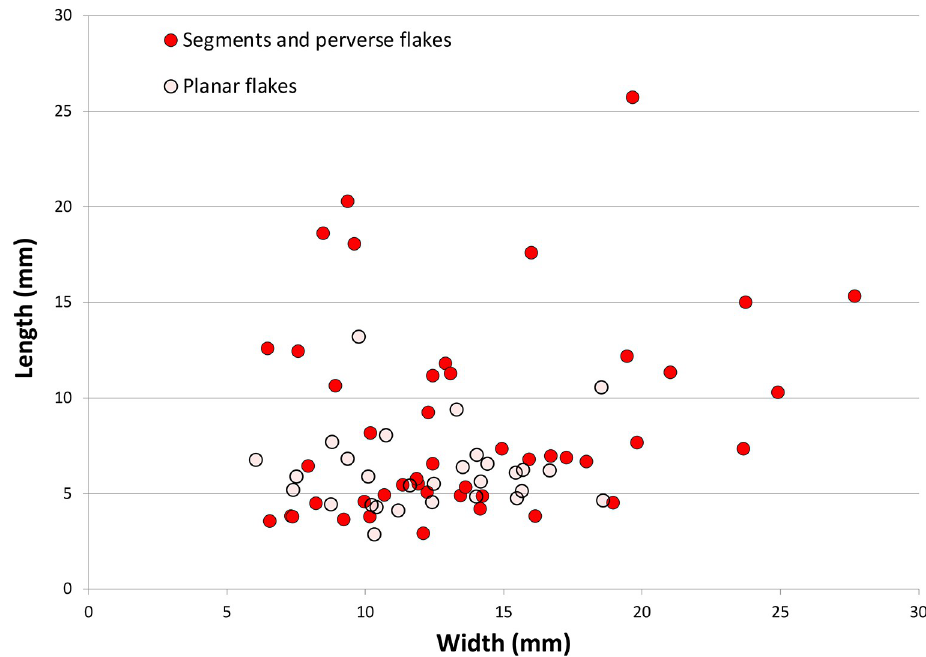
Fig 20. Scatterplot comparing the elongation of byproducts from truncating and backing flakes, Horizon IV, Saruq al-Hadid.